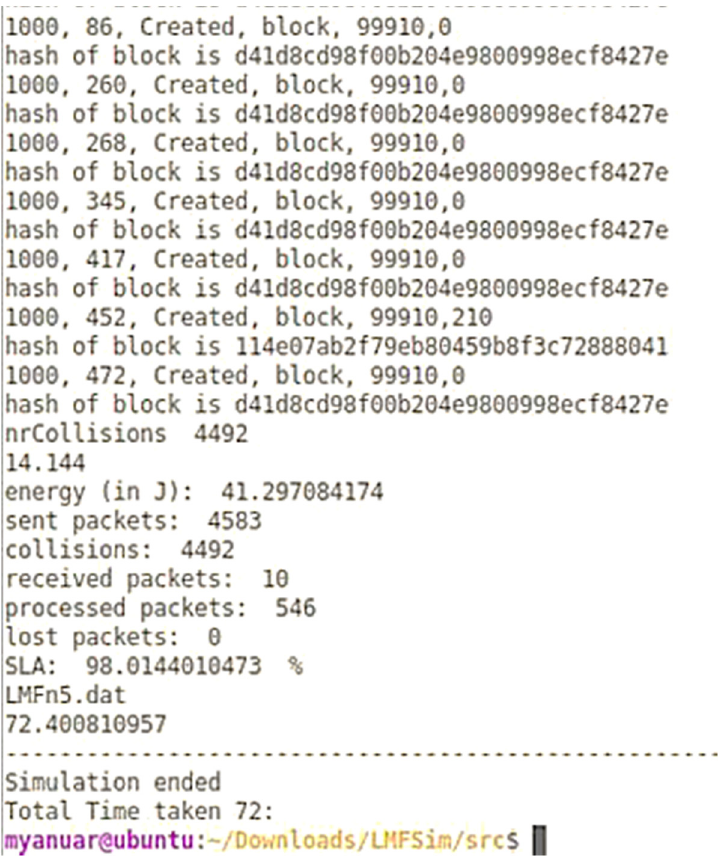
Figure 6. Simulation result using LMFSim.